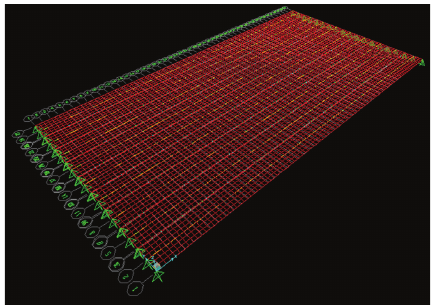
Figure 4: SAP model of end span of BR